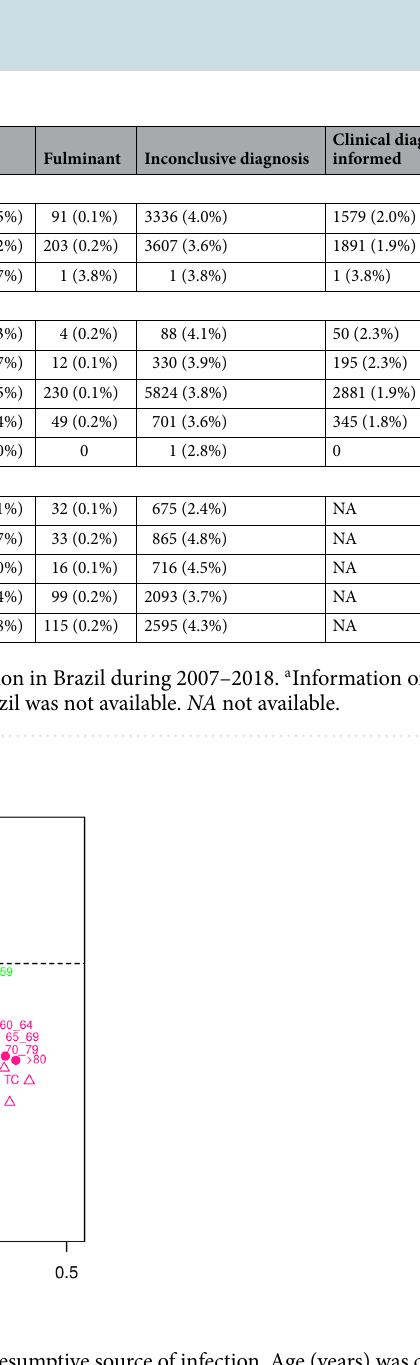
Figure 1. Map of the relationship between age and presumptive source of infection. Age (years) was categorized as < 1; 1–4; 5–9; 10–14; 15–19; 20–39; 40–59; 60–64; 65–69; 70–79; > 80. Presumptive sources of infection were coded as Sexual (S); Transfusion (T); Intravenous drug use (Dr), Vertical (V), Occupational Accident (AT), Hemodialysis (H), Household Contact (Do), Surgical Treatment (CT), and Dental Treatment (TD). This figure was created by using the R software 19 version 3.5.3 (https:// www.R- proje ct.